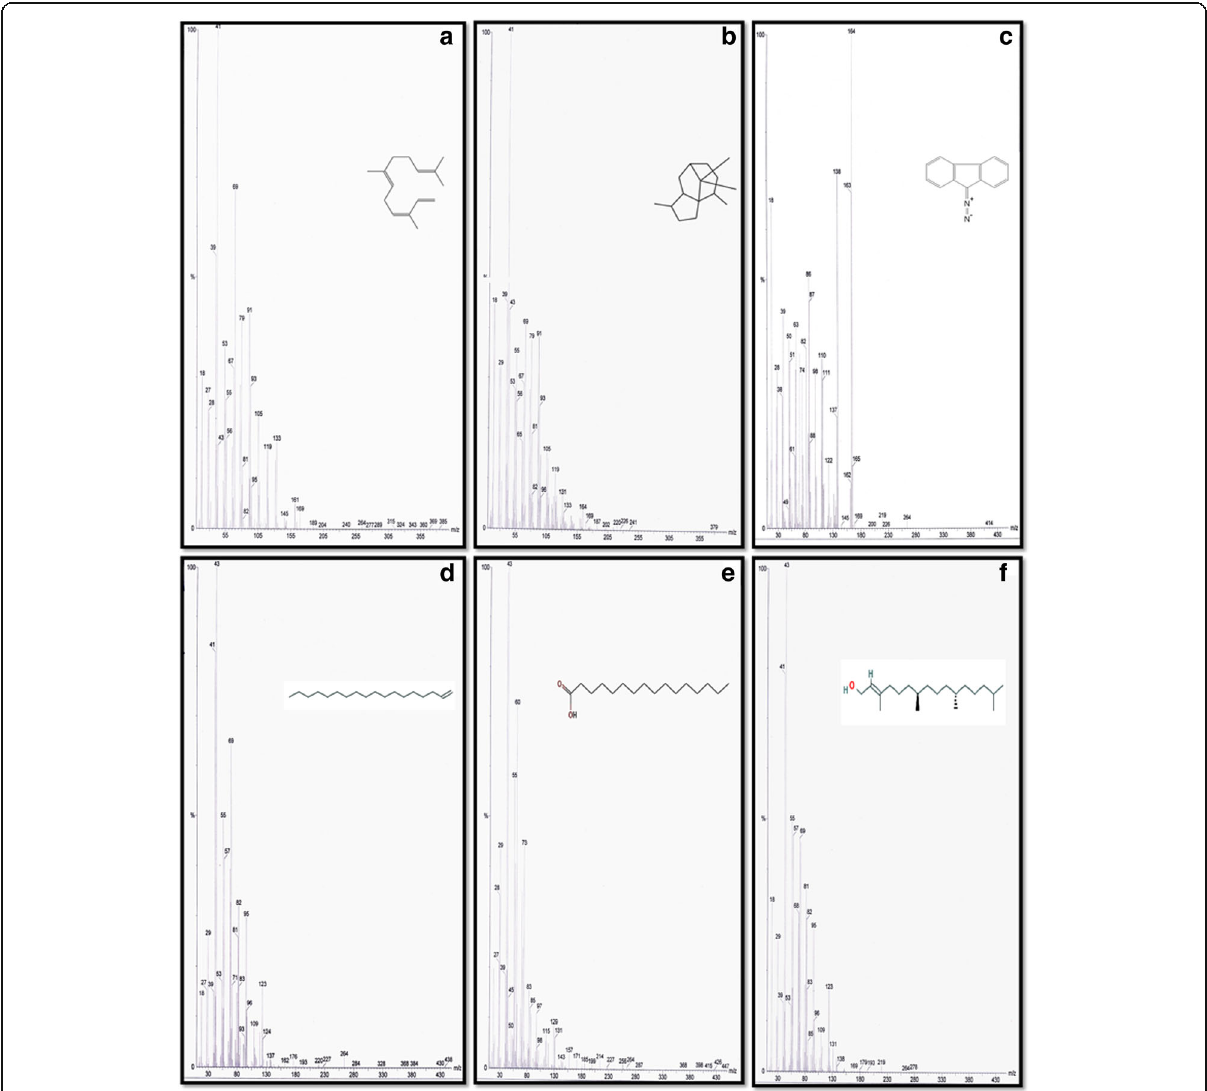
Fig. 8 GC-MS Chromatogram detected six volatile compounds from methanolic extract of Bidens pilosa plant compared with NIST library. a 1,3,6,10-Dodecatetraene, 3,7,11-trimethyl-(Z,E); ( b ) 1H-3A, 7-Methanozulene, Octahydro-1,4,9,9-tetramethyl; ( c ) 9H – Fluorene,